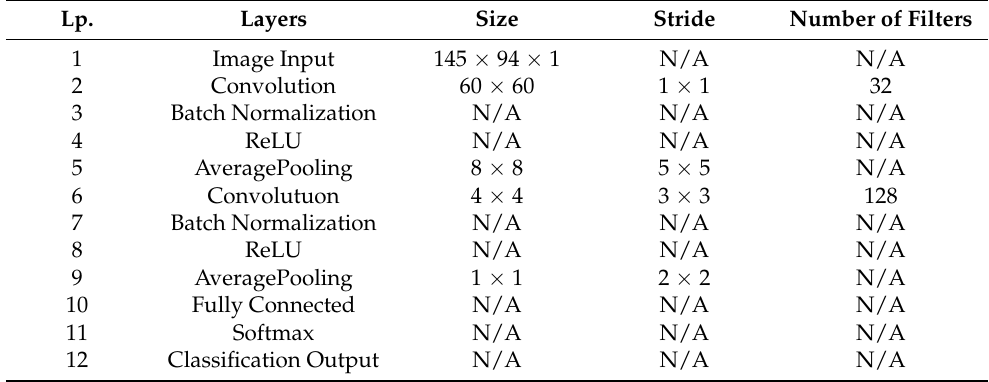
Table 3. Structure of the DCNN [26].